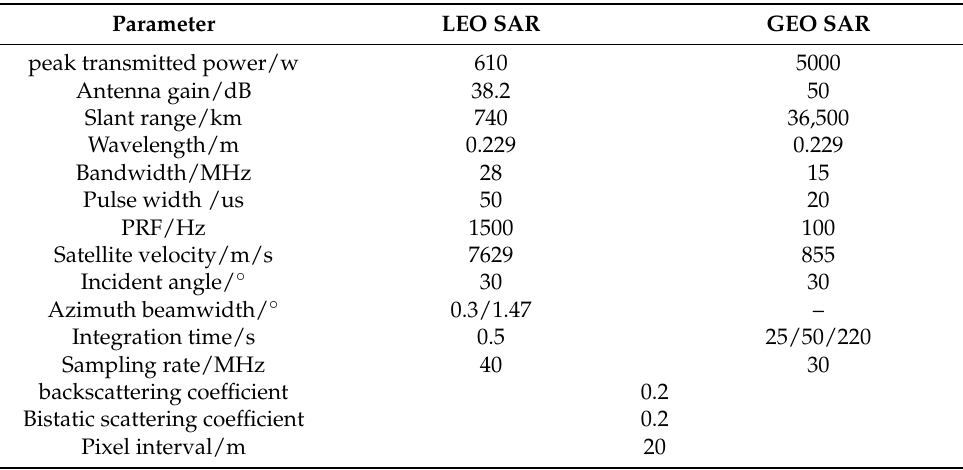
Table 2. Parameters of LEO SAR and GEO